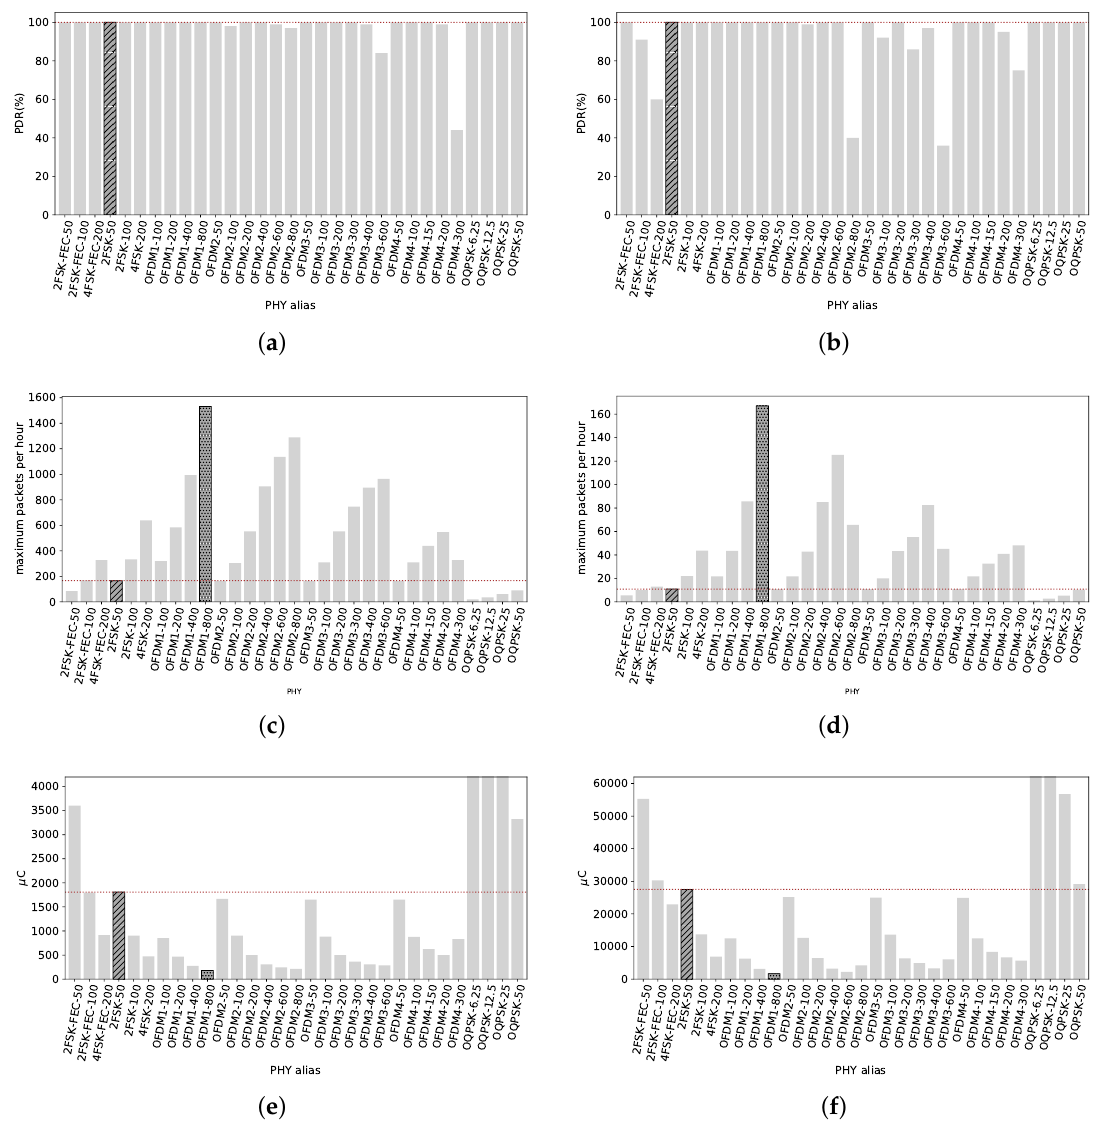
Figure 9. Smart Agriculture, 337 m. The PDR for all radio setting considering short and long packets is high. Using high data rates does not impact in the reliability while reducing electric charge consumption and increasing the number of packets exchange within the 0.1%duty cycle regulation. ( a ) Packets of 127 B. Almost all radio settings with a PDR close to 100%, including those with the higher data rates; ( b ) Packets of 2047 B. PDR of some radio settings drops, such as OFDM2-800, 2FSK-100 and 4FSK-200. The whole OFMD option 1 PHYs stay at 100%, as well as the reference 2FSK-50 and all the O-QPSK radio settings; ( c ) Maximum amount of short packets that can be transmitted per hour. OFDM1-800 can transmit up to 1531 packets while the reference just 166.; ( d ) Maximum amount of long packets that can be transmitted per hour. OFDM1-800 can transmit up to 167 packets, more than 10 times the reference with just 11 packets; ( e ) Average electric charge consumed per 127 B packet transmitted. OFDM1-800 is the less power-hungry, with 178 µ C consumed, against the 1800 µ C needed by 2SFK-50 to transmit the same packet. The rest of the high data rates OFDM PHYs also consume significantly less electric charge than the reference; ( f ) Average electric charge consumed to send a long packet. Still OFDM1-800 is the less electric charge-consuming, with 1637 µ C per packet, whereas the reference consumes 27.5 mC. Figure 9e depicts the average electric charge consumption per packet the radio needs in order to send a 127 B packet. The reference 2FSK-50 needs on average 1800 µ C. The lowest amount of